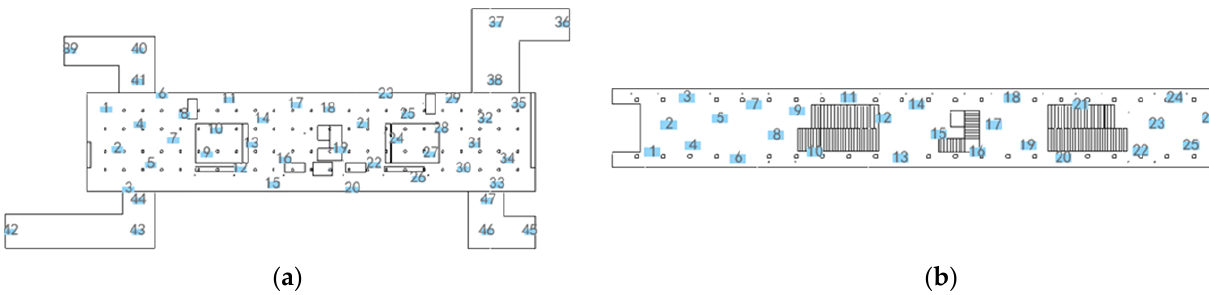
Figure 15. Arrangement of OLHS sampling points: ( a ) Concourse floor; ( b ) Platform floor.